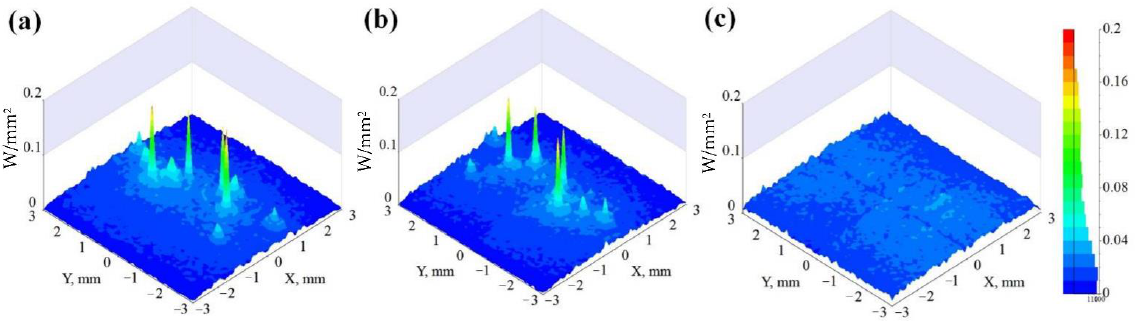
Figure 14. Light distribution on the receiver using three types of homogenizer: ( a ) multi-channel reflective box, ( b ) conventional scattering box, and ( c ) integrated version termed multi-channel scattering box.